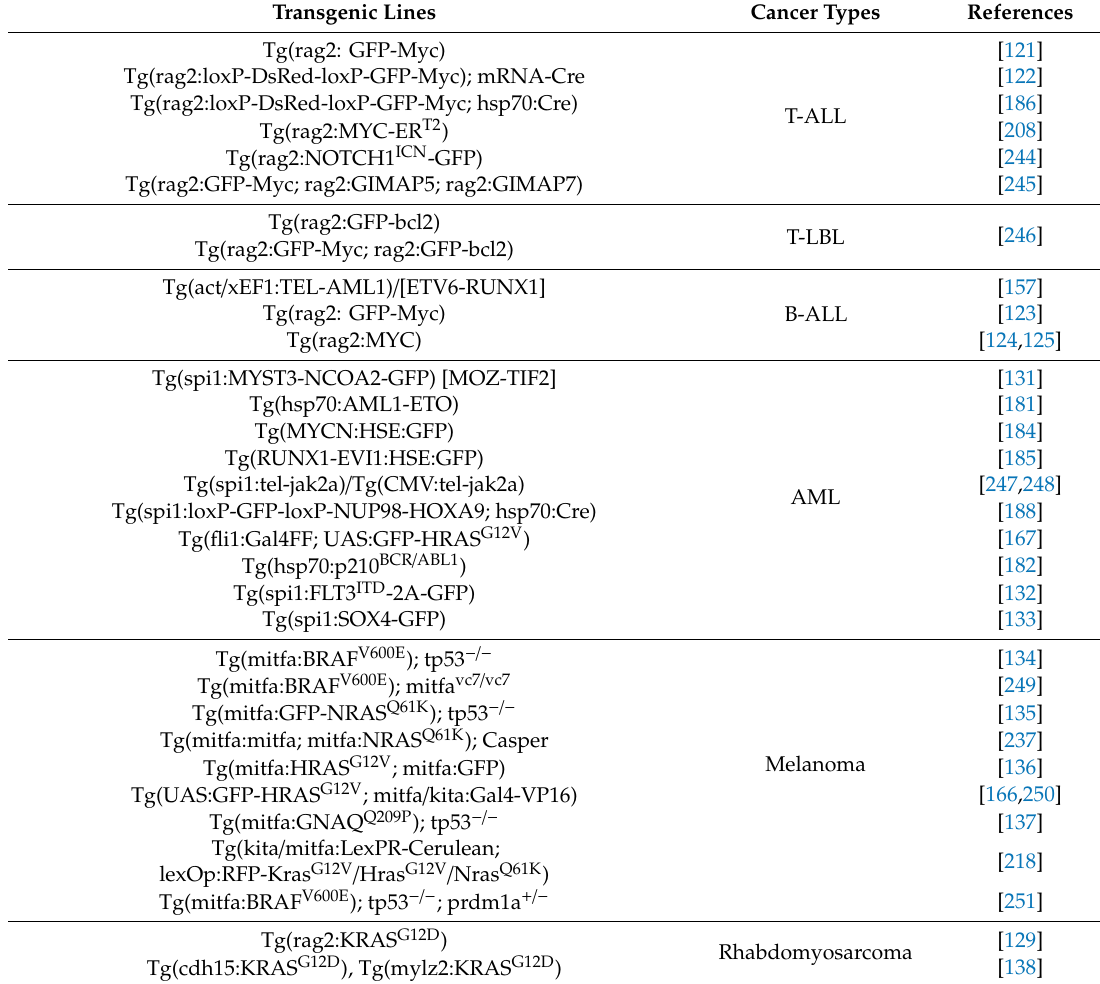
Table A1. Transgenic zebrafish lines developing